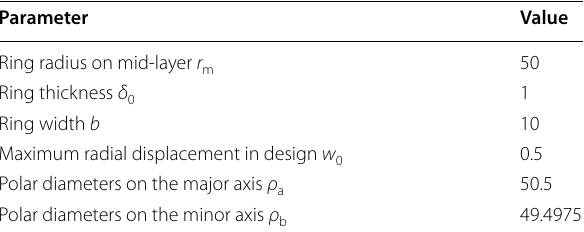
Table 1 Structural parameters of ring and elliptical cam ( mm) Parameter